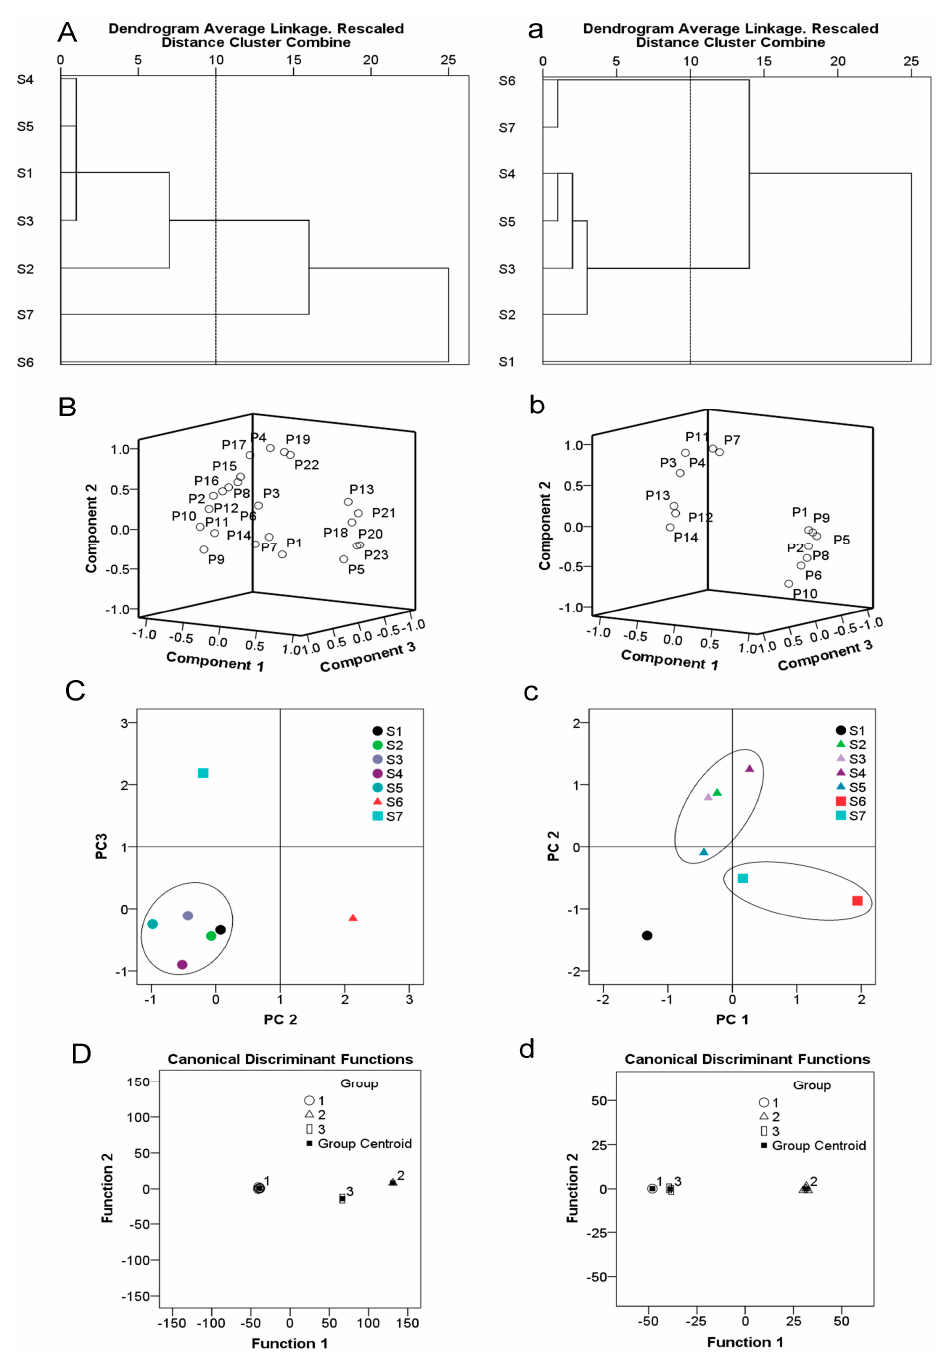
Figure 2. HPLC chemometrics analysis of different E. ulmoides varieties. ( A , a ): Dendrograms of hierarchical cluster analysis (HCA) for leaf ( A ) and bark ( a ) samples. ( B , b ): Loading plot generated from principal component analysis (PCA) for leaf ( B ): peaks 1–23) and bark ( b ): peaks 1–14) samples. ( C , c ): Score plot generated from principal component analysis (PCA) for leaf ( C ) and bark ( c ) samples. ( D , d ): Canonical discrimination analysis (DA) of HPLC chromatograms for leaf ( D ) and bark ( d ) samples.